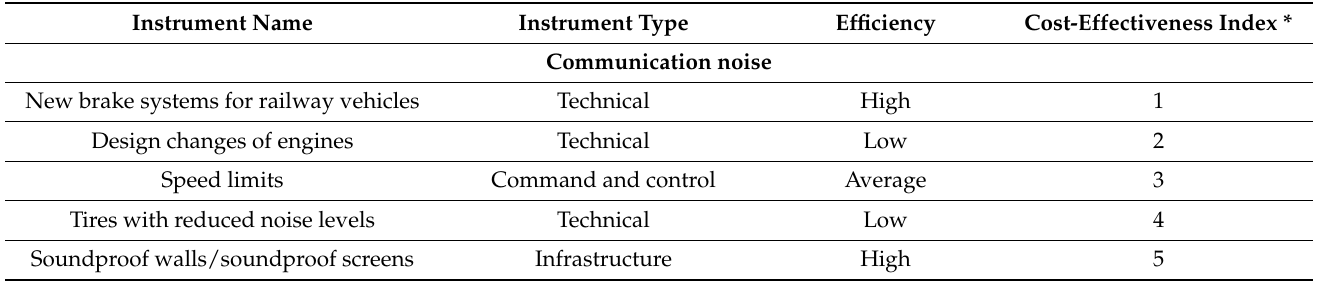
Table 1. Instruments for the internalisation of external costs of transport related to noise and exhaust emissions. Instrument